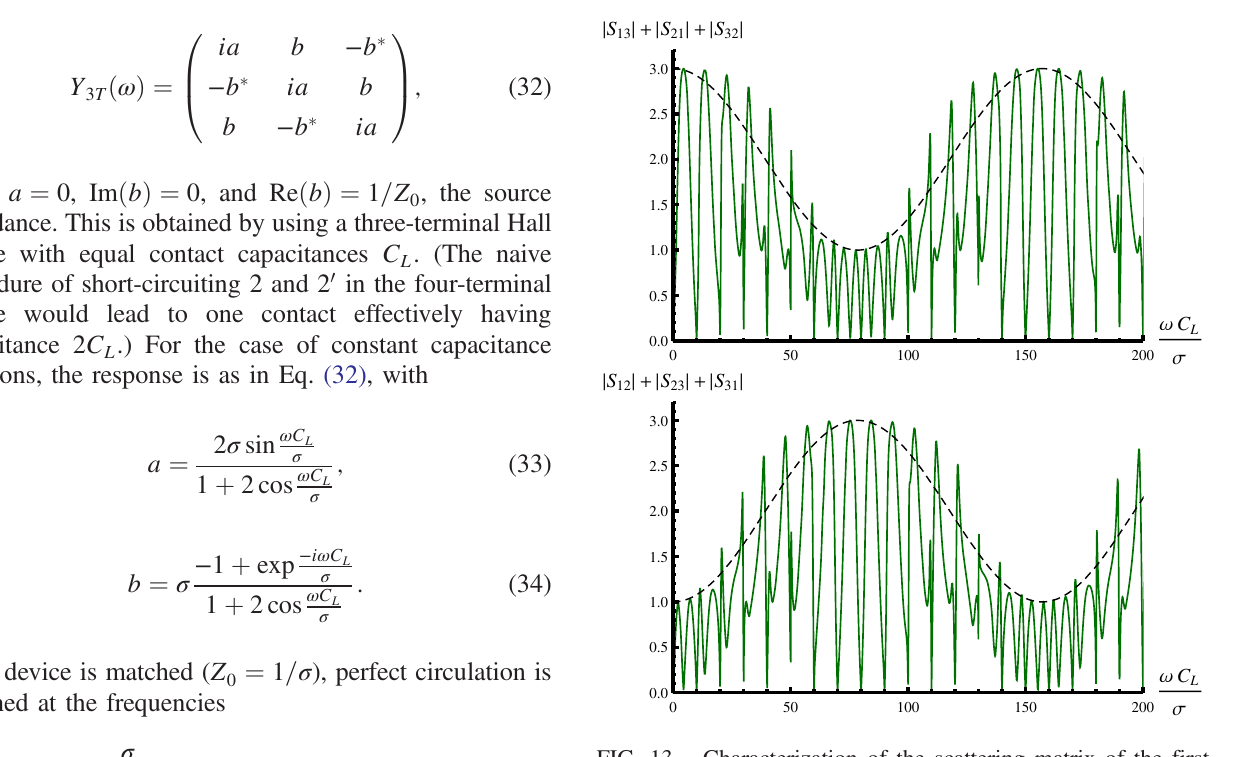
FIG. 13. Characterization of the scattering matrix of the first Carlin construction (Fig. 11) with rounded capacitances. Round- ing is as in Eq. (30), with λ ¼ L= 12 . Upper panel: jð S Þ þ ð S Þ þ ð S Þ j . Because of unitarity, the maxi- 3 T; λ 3 T; λ 3 T; λ 13 21 32 mal value this sum can attain is 3, and at such a point, perfect counterclockwise ( 1 → 2 → 3 → 1 ) circulation is achieved. We see that when the slow modulation due to the rounding begins to occur, perfect gyration is lost. Bottom panel: jð S Þ þ ð S Þ þ ð S Þ j . We see that the modulation 3 T; λ 3 T; λ 3 T; λ 31 12 23 causes this quantity to periodically attain the value 3, meaning that perfect clockwise circulation ( 1 → 3 → 2 → 1 ) is